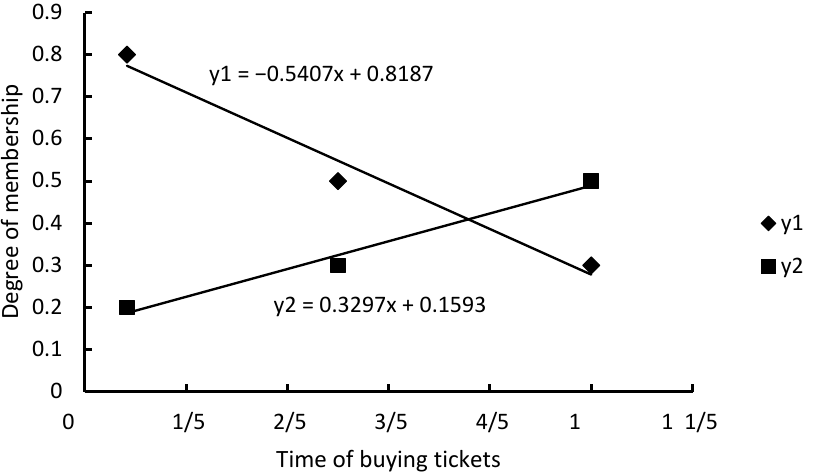
Figure A31. Single factor evaluation for the index of time of buying tickets (1 day before depar- ture).